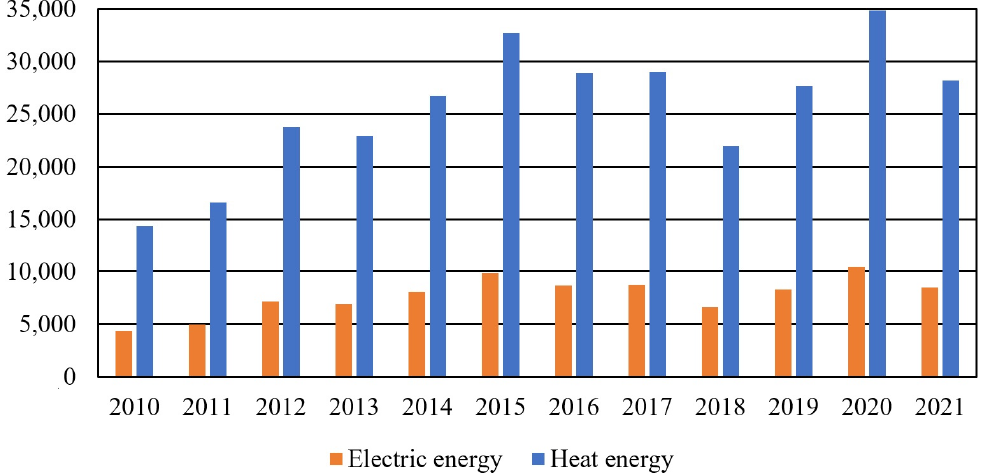
Figure 4. Thermo ‐ and electric energy equivalents of the potentials of crop production by ‐ producys Figure 4. Thermo- and electric energy equivalents of the potentials of crop production by-producys in Lithuania (thousand GJ). in Lithuania (thousand